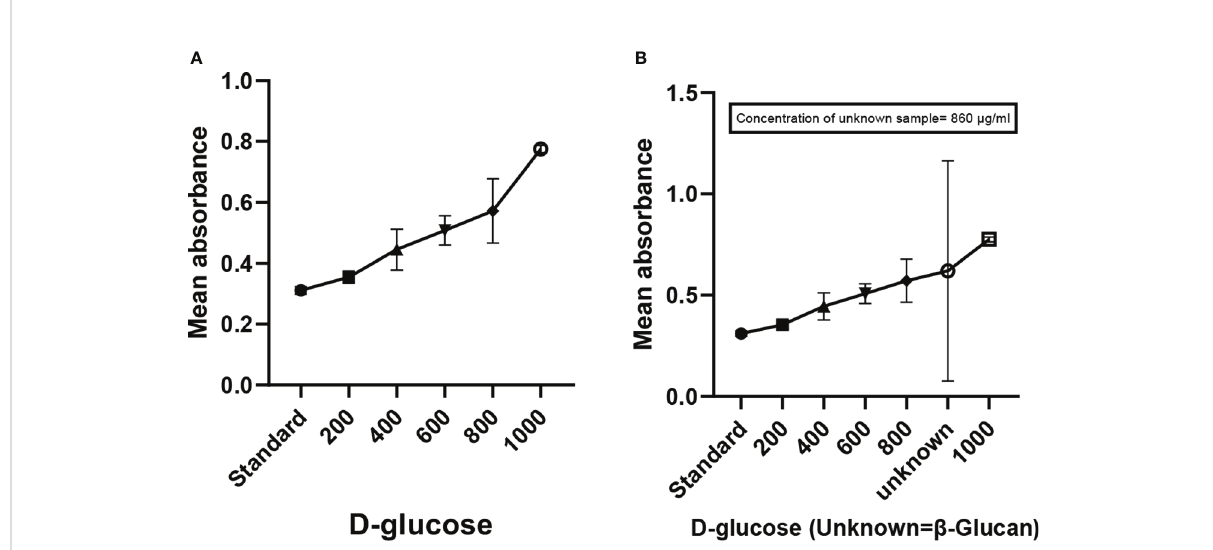
FIGURE 2 Anthronetestshowingthequanti fi cationofcarbohydrates( b -glucan). (A) Graphshowingtheincreaseinabsorbancewiththeincreaseinconcentrationofsugar. (B) Graphofquantitativeestimationofunknownsample.Allthedataexpressedasthemean±standarddeviationofthemean(SD)fromtriplicateexperiments.